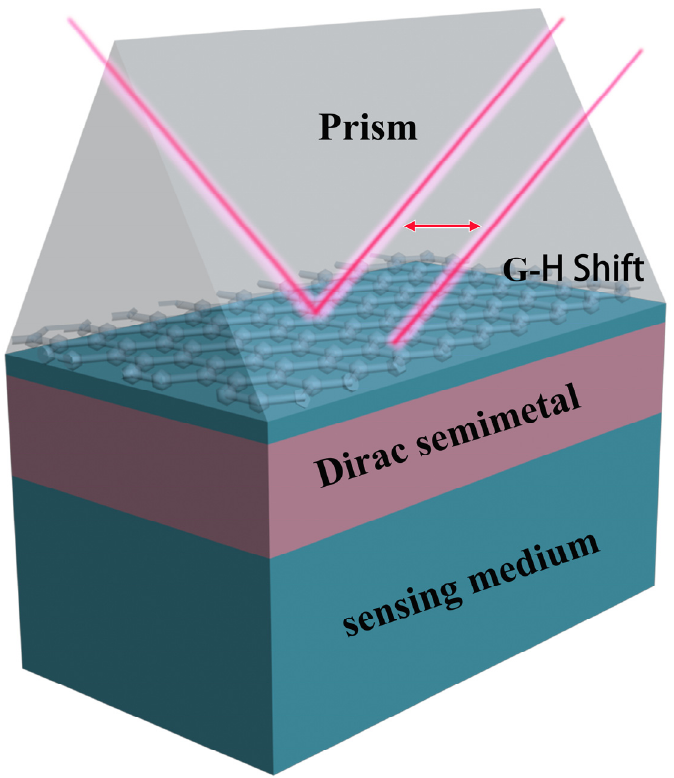
Figure 1. Schematic of the proposed structure that enhanced the GH shift, which contains layers of prism, graphene, sensing medium, and Dirac semimetal.